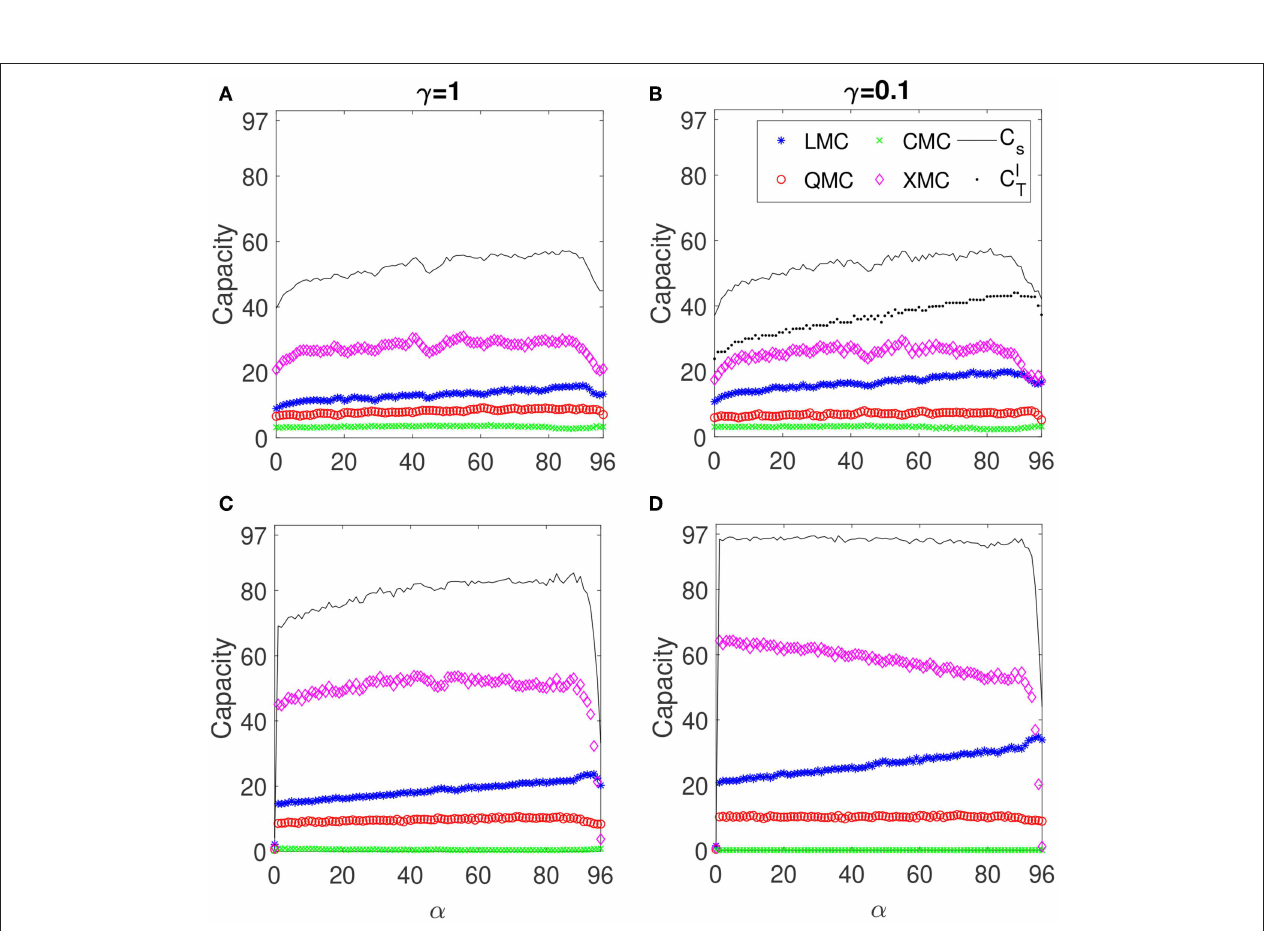
FIGURE 4 | Memory capacities of the one delay-based RC as a function of α . Left panels (A,C) : γ = 1. Right panels (B,D) : γ = 0.1. Top panels (A,B) : T = θ/ 0.2. Bottom panels (C,D) T = 0. The blue stars, red circles, green crosses, pink diamonds correspond to the LMC, QMC, CMC, XMC, respectively. The solid black line is the C s . The dotted black line in (B) is the C l T